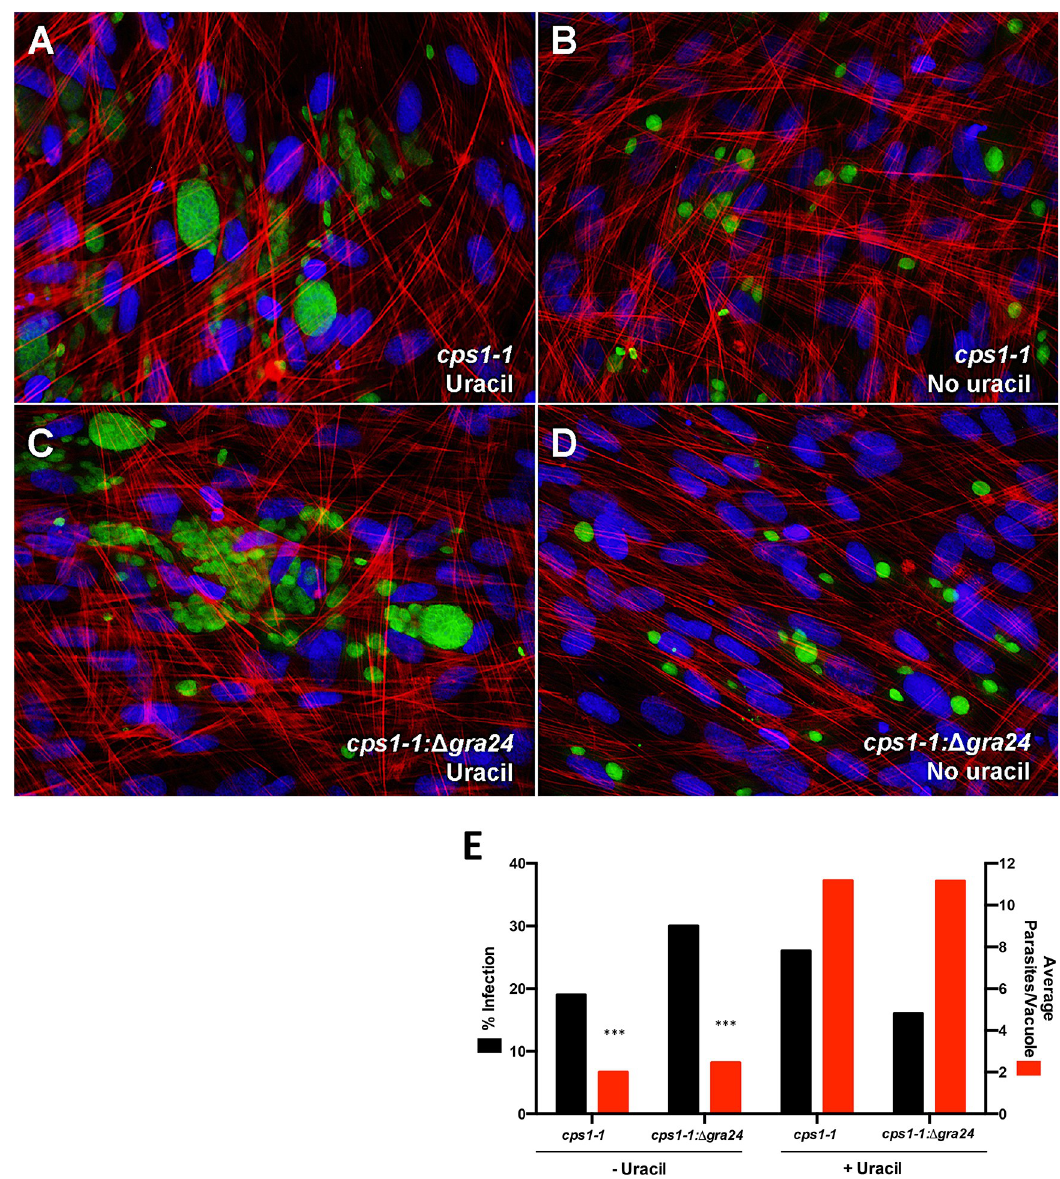
Fig 3. Both cps1-1 and cps1-1 : Δ gra24 tachyzoites require supplemental uracil for sustained replication. Tachyzoites of strains cps1-1 or cps1-1 : Δ gra24 were inoculated onto human foreskin fibroblast monolayers in the presence ( A and C ) or absence ( B and D ) of exogenous uracil. Two days after infection, monolayers were fixed and stained with FITC conjugated anti- Toxoplasma antibody (green), phalloidin-Texas red to stain host cell actin, and DAPI (blue) to stain nuclei. Images were collected under 40x magnification. ( E) Percent infection and the average parasites per vacuole were quantified in cps1-1 and cps1-1 : Δ gra24 infected fibroblasts in the presence and absence of exogenous uracil. This experiment was repeated twice with the same result. Data shown are the mean counts of three independent experiments. Statistical significance was assessed using Mann-Whitney test comparing cps1-1 (+/-) exogenous uracil and cps1-1 : Δ gra24 (+/-) exogenous uracil ( E ) ( ��� p <